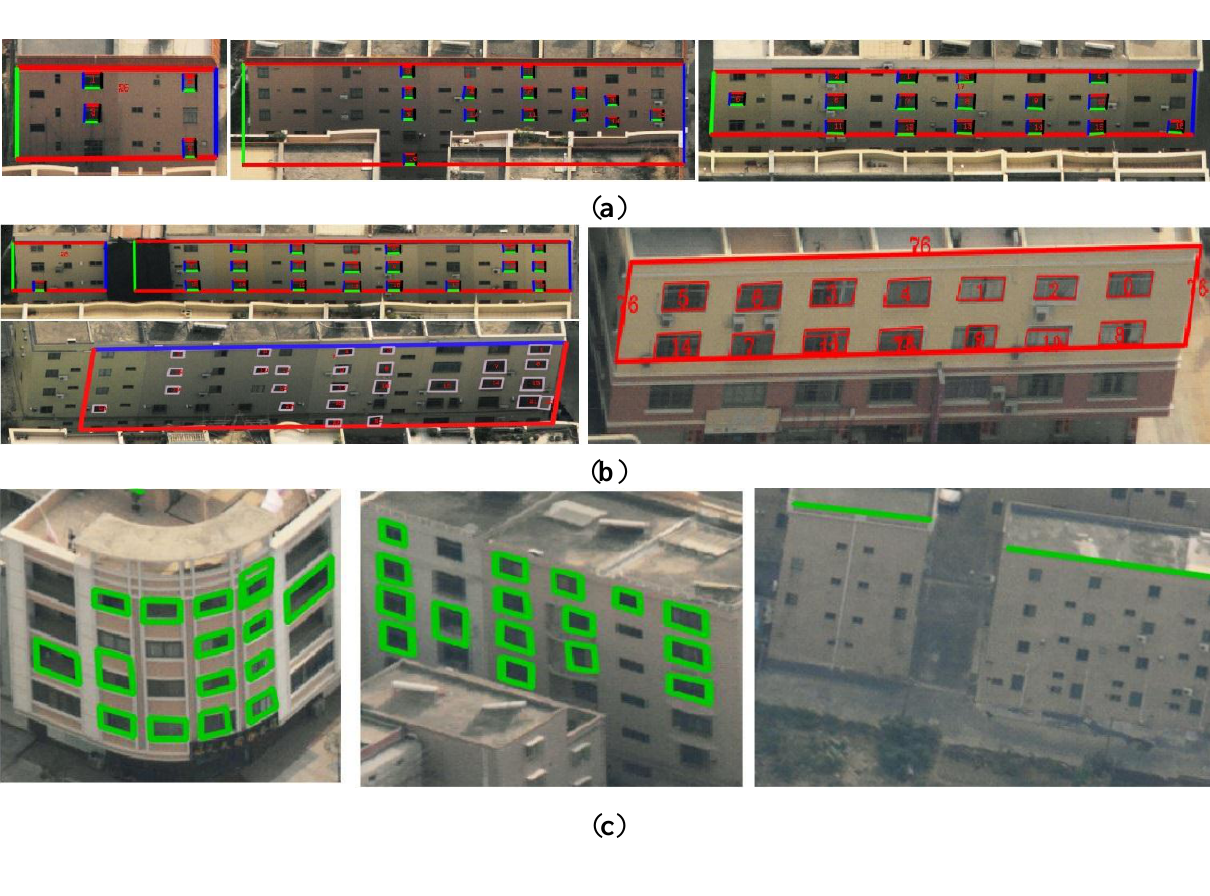
Figure 14. Three main types of extracted façades. ( a ) Classical types of completely correct detections, which are similar to reality. The left image shows the ideal case. Other objects are partially blended because of occlusion (middle), and part of the façade is not included in the regional feature because the non-obvious window features cause occlusion (right); ( b ) Several types of non-integrity. Deficiencies or splitting are observed due to non-integrity of the wall-roof edge (left), and the bottom façade is missing due to the failure to detect the window regional features (right); ( c ) Main types of missing façades. Arc-shaped façades (left) and a non-distinctive edge between the wall and the rooftop (middle) are observed. Nearly all of the window features are not extracted from a façade